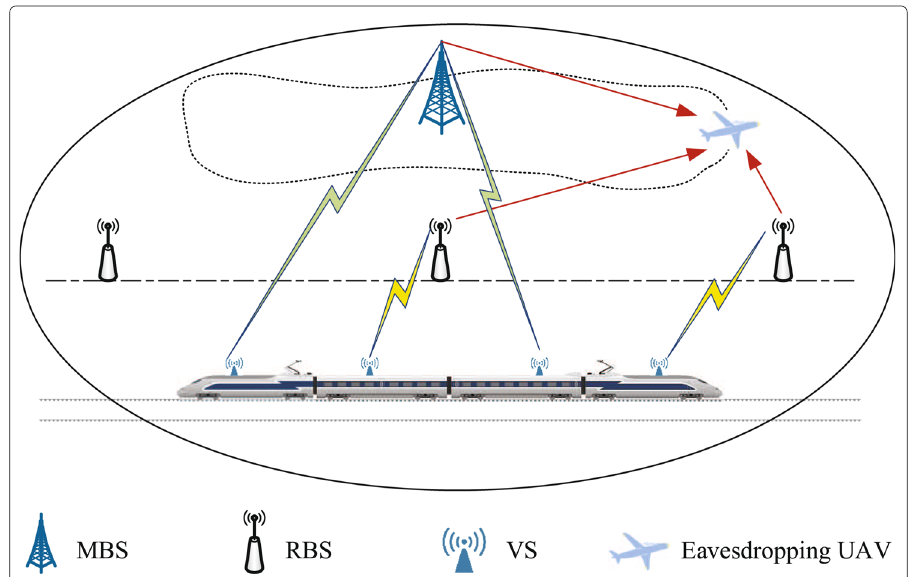
Fig. 1 System model for secure HSR